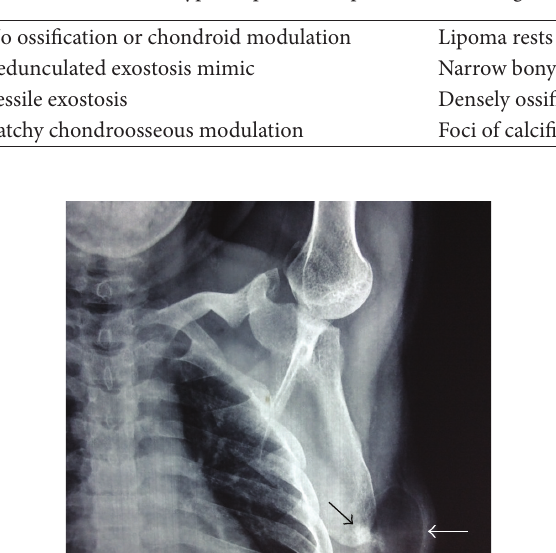
Table 1: Types of parosteal lipoma based on degree of chondroid modulation and endochondral ossification [1, 3].